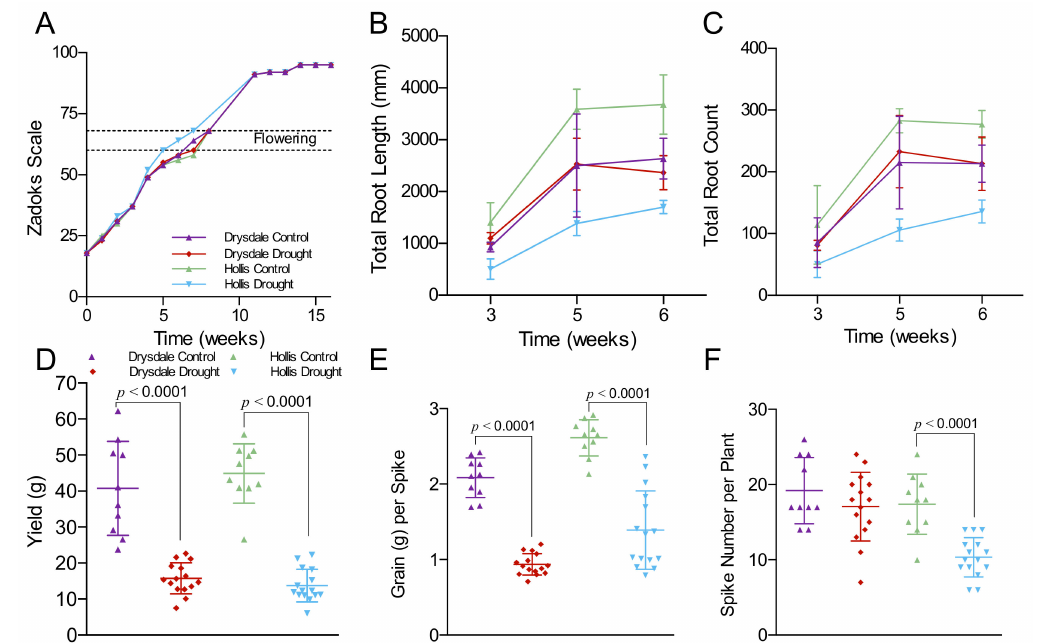
Figure 1. Impact of drought stress on development and yield. ( A ) Comparison of Hollis and Drysdale plant development under normal watering and drought. First and last Zadoks sages corresponding to flowering are denoted by the dotted lines. The average total root length ( B ) and total root count ( C ) of control and drought-stressed Drysdale and Hollis plants. The error bars represent the standard deviation of values from two watered control bins or three drought stress bins each containing five plants. The average yield per plant ( D ), grain weight per spike ( E ), and spike number per plant ( F ) of control and drought-stressed Drysdale and Hollis. Each data point represents average values of the individual plants, n = 10 for control and n = 15 for drought stress treatment. The statistical significance was analyzed using Student’s t -test. Grain yield was significantly reduced (<0.0001) in both genotypes under drought